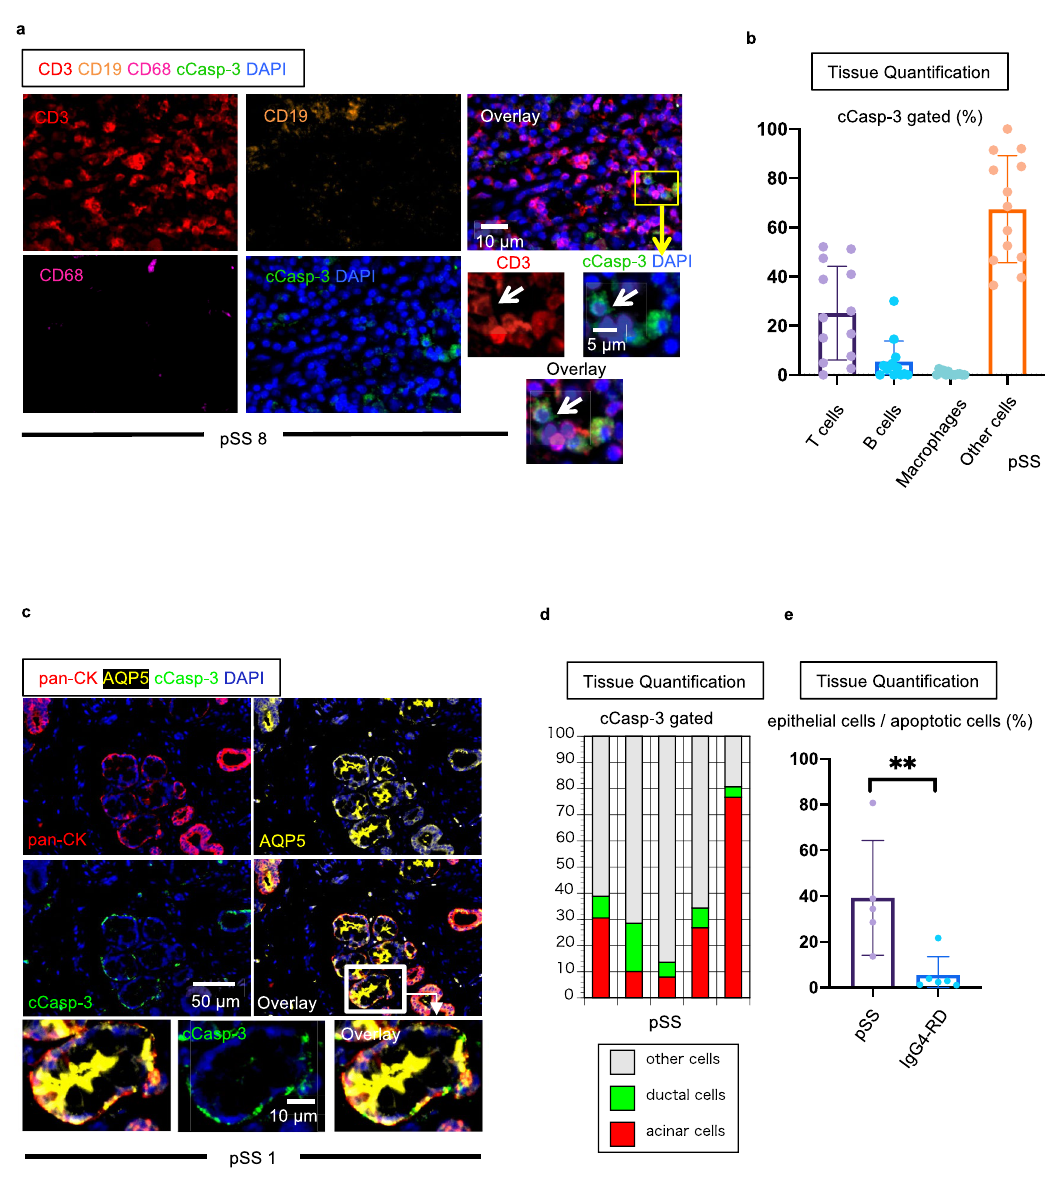
Figure 4. T cells, acinar cells and ductal cells account for a large proportion of apoptotic cells in tissues from SS patients. ( a ) Representative multi-color immunofluorescence image of CD3 (red), CD19 (orange), CD68 (purple), cCaps-3 (green) and DAPI (blue) staining in a pSS lesion. White arrows indicate apoptotic CD3 + T cells. ( b ) Proportions of apoptotic cells in pSS (n = 10) accounted for by T cells (red), B cells (green), Macrophages (blue) and other cells (gray). ( c ) Representative multi-color immunofluorescence images showing pan-CK (red), AQP5 (yellow), cCasp-3 (green) and DAPI (blue) staining in a pSS lesion. White arrows indicate a pan-CK + cCasp-3 + cell. ( d ) Proportions of apoptotic cells in pSS (n = 5) accounted for by acinar cells (red) (AQP5+, pan-CK+), ductal cells (green) (AQP5−, pan-CK+) and other cells (gray) (AQP5±, pan-CK−). ( e ) Relative proportions of cCasp-3 + cells expressing pan-CK or AQP5 or both in pSS (n = 5) and IgG4-RD (n = 6). Mann–Whitney U test used to calculate p-value. Error bars represent mean ± SEM. **p < 0.01; ***p <